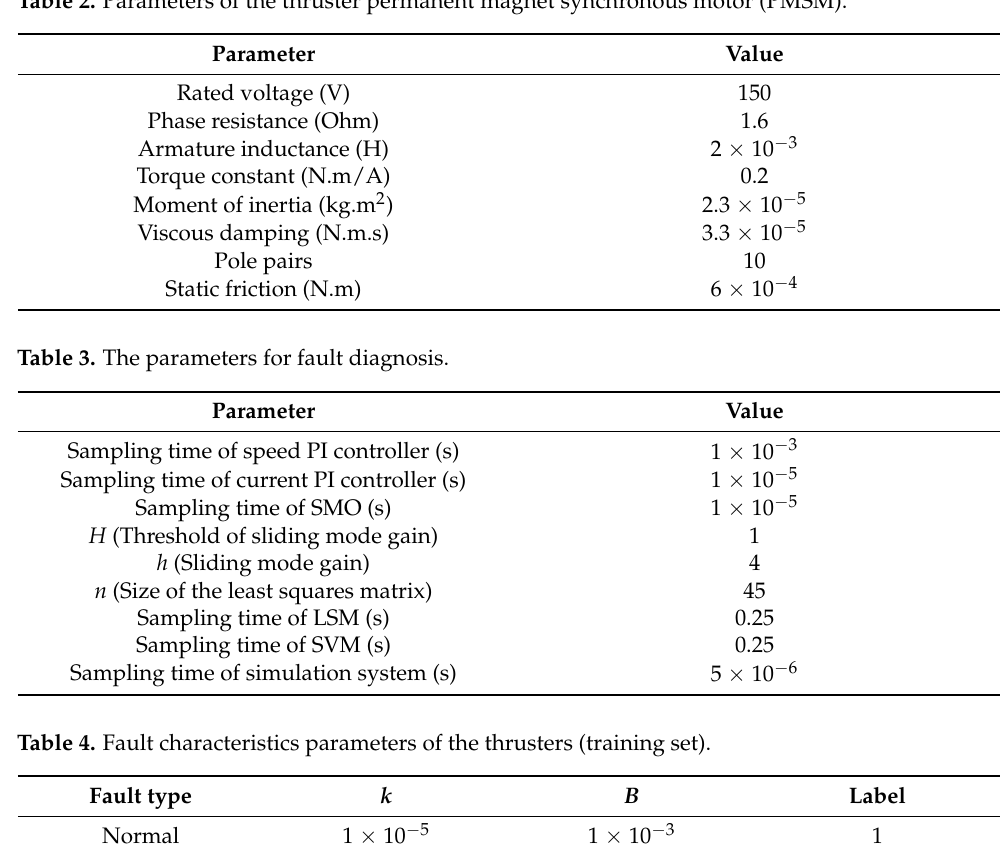
Table 2. Parameters of the thruster permanent magnet synchronous motor (PMSM).